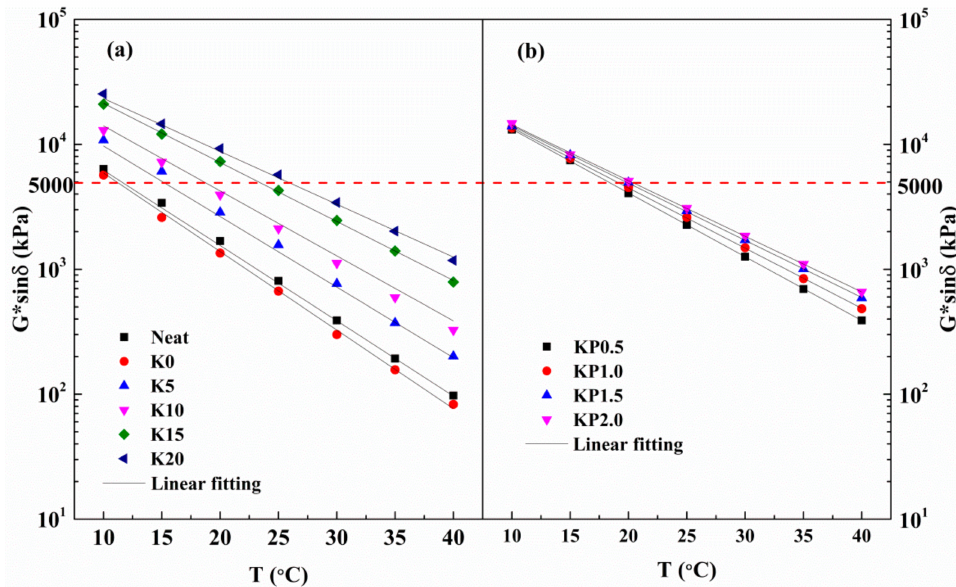
Figure 11. Temperature dependence of G*sin δ for all tested samples: ( a ) SBS/OSDOA modified asphalts; ( b ) composite modified